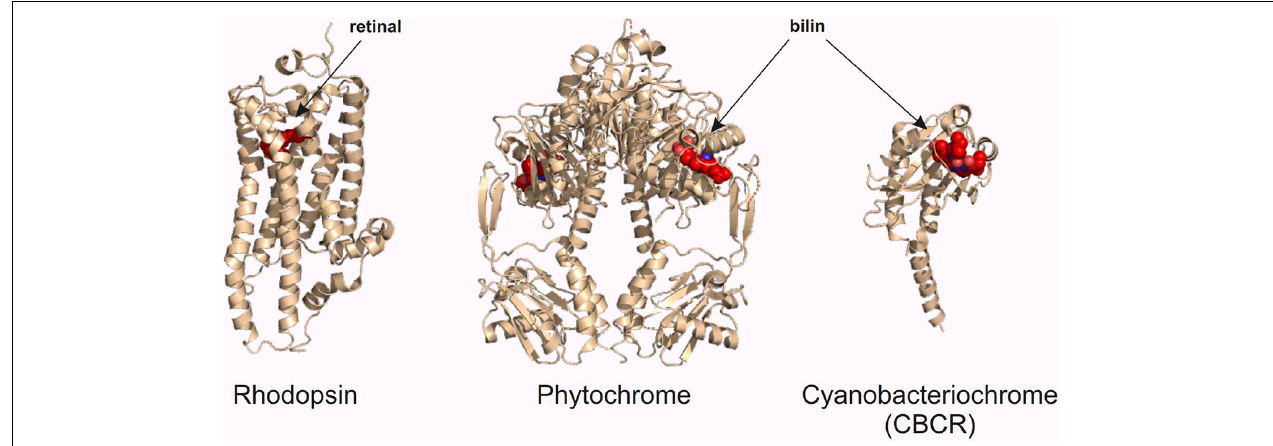
FIGURE 3 | Red light optogenetic actuator classes. Example structures of the three classes of the red light optogenetic actuators. Note that only the photosensory fragment of each protein is shown. The structures are to scale relative to each other. Each structure was derived from the following Protein Data Bank (Berman et al., 2000) coordinates: 3AYN (rhodopsin) (Murakami and Kouyama, 2011), 4O0P (phytochrome) (Takala et al., 2014), and 6UV8 (cyanobacteriochrome) (Bandara et al., 2021). The figure was created with the PyMOL Molecular Graphics System version 2.3.3 (Schrödinger,